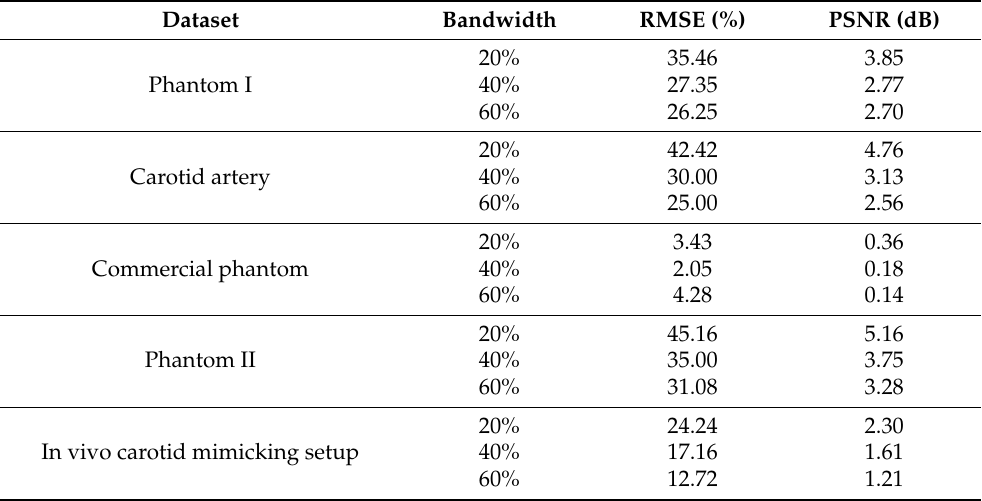
Table 3. The improvements obtained for all test datasets with the different models and state-of-the-art techniques for 20%, 40% and 60%